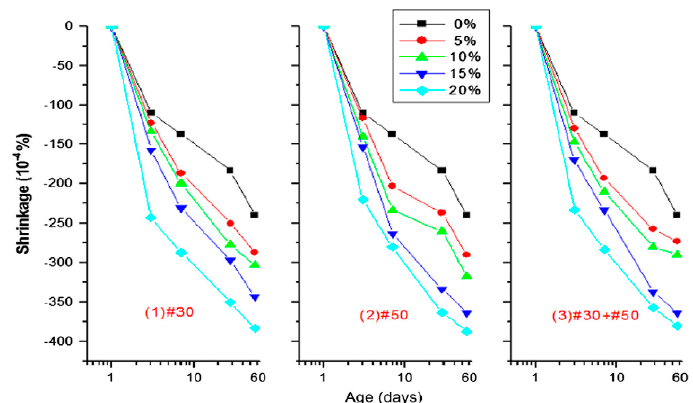
Figure 9. Effect of rubber aggregate on shrinkage [38]. Reproduced with permission from W. H. Yung,